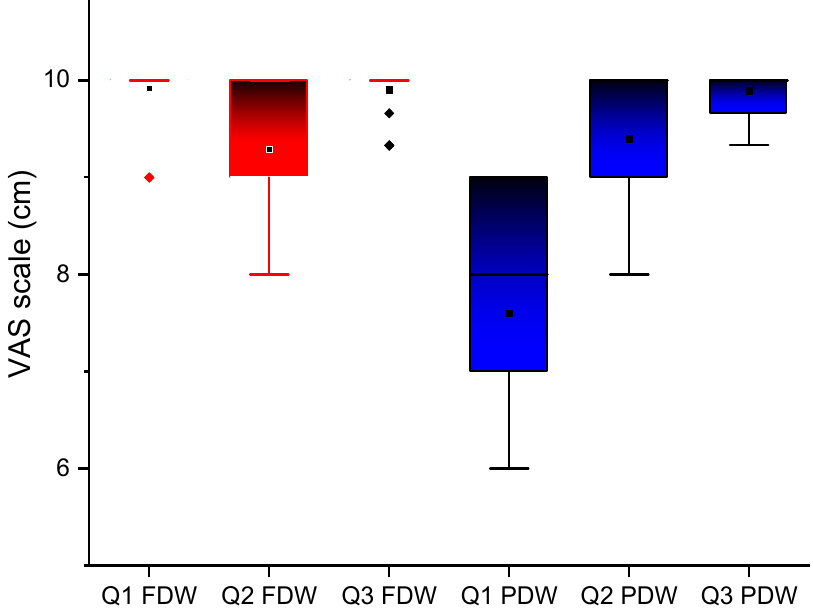
Figure 9. Assessment of response to the VAS questionnaire (0 meaning not satisfied at all and 10 meaning completely satisfied): Q1: How was your experience with data collection (dental impres- sion)?; Q2: How was your experience with dental implants insertion?; Q3: How do you describe your postoperative discomfort considering pain, swelling, bleeding? The boxplots symbols signifi- cance: box—interquartile range (IQR), range within IQR,—median line, □ mean, ◊ outliners. Red plots are for FDW group and blue plots are for PDW group. Most of the patients in FDW grouped scored 10 at Q1 (minimum 9) comparing to PDW (scores between 6 and 9). Dental implants inser- tion and postoperative patient’s feedback was favorable, for both groups (VAS score between 8 and 10).